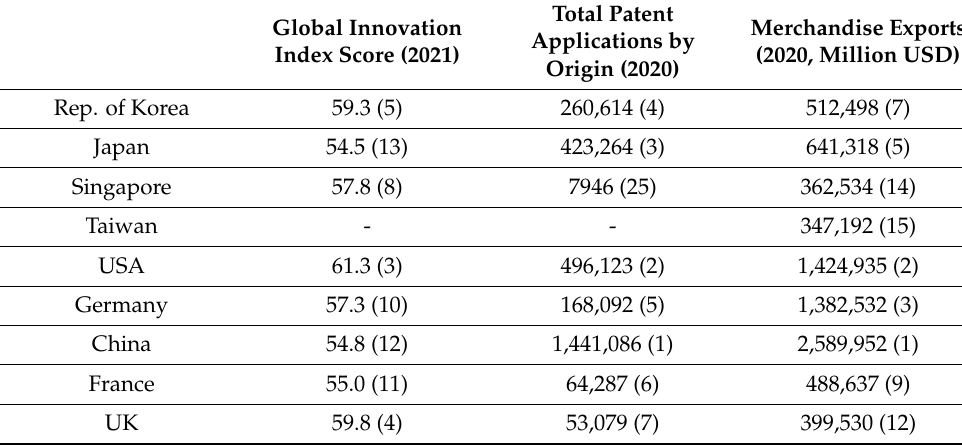
Table 1. Technological, Economic Advantages of Asian Middle Power Countries. Global